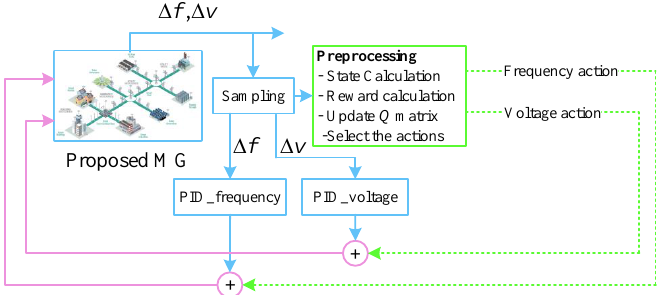
Figure 10. The implementation idea of the proposed control method based on RL.